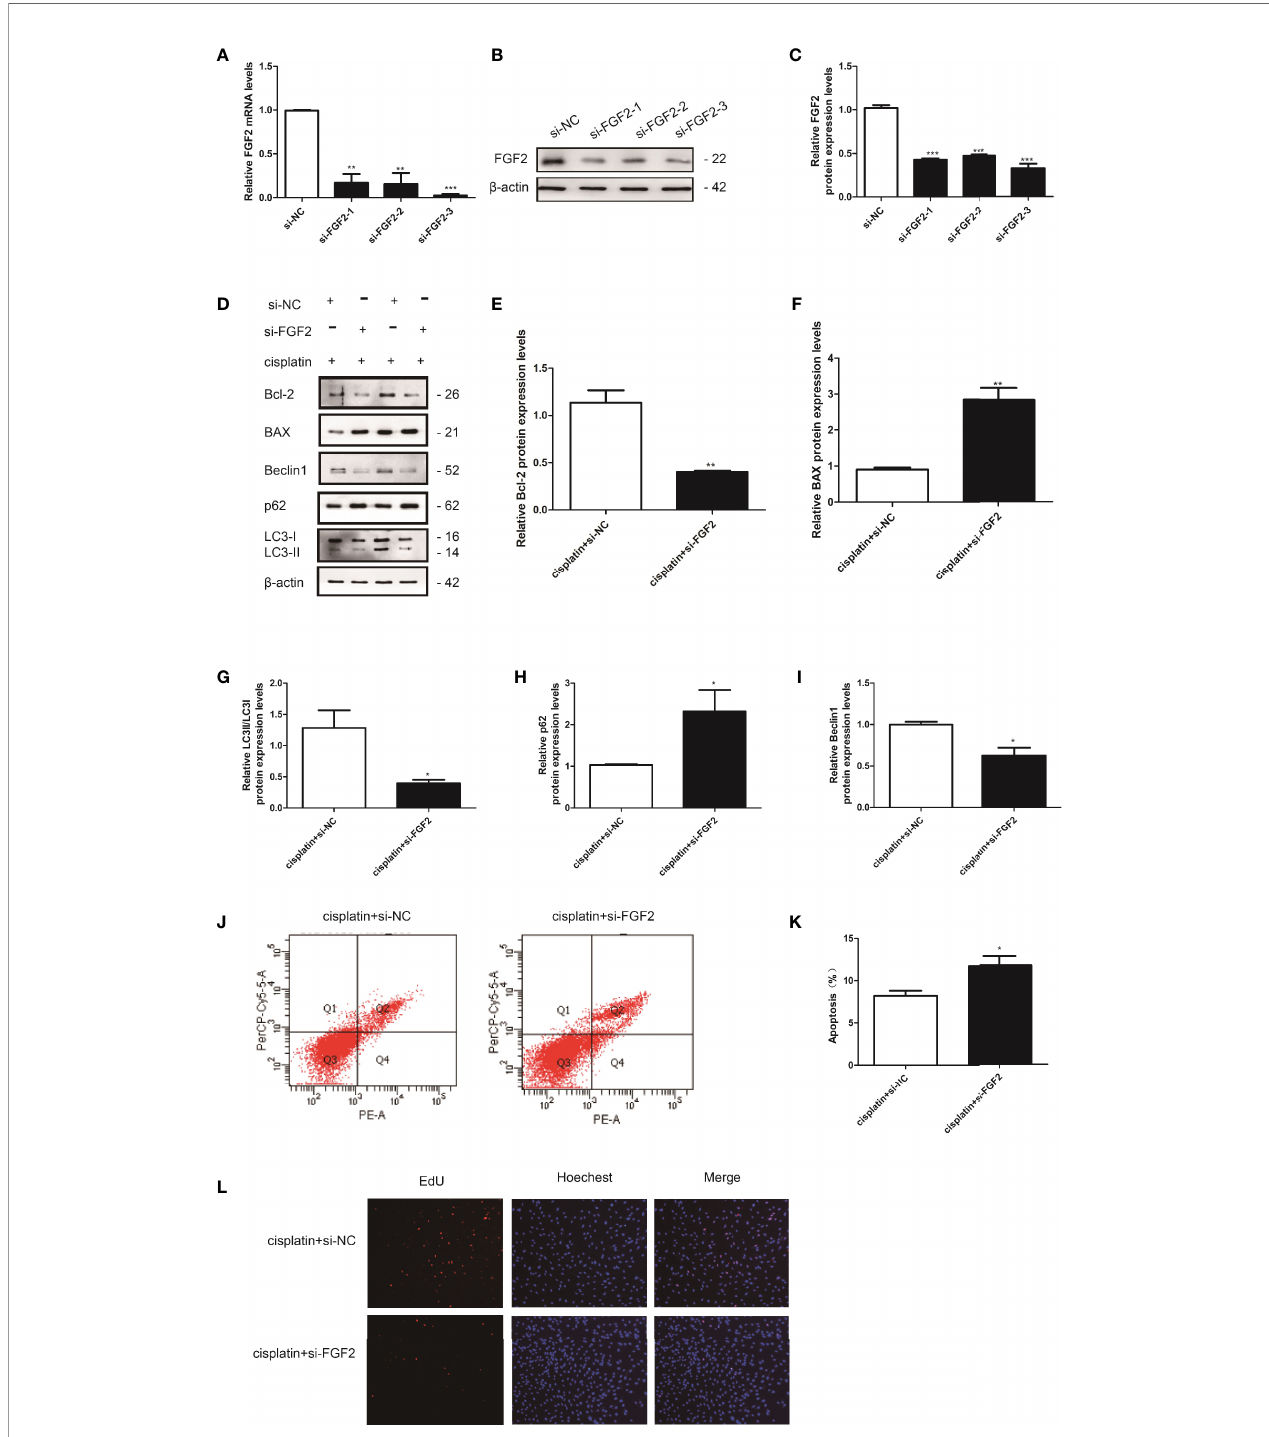
FIGURE 4 | Knockdown of FGF2 in injured KGN cells promoted cell apoptosis via inhibiting autophagy. (A – C) The transfection ef fi ciency was con fi rmed by qRT- PCR and Western blotting. (D) The injured KGN cells were transfected with si-FGF2 (50 nM) for 48 h. The expression of Bcl-2, BAX, LC-3, Beclin1, and p62 was monitored by Western blot. Here, b -actin was used as a loading control. (E – I) Quantitative comparison of the different expression levels of Bcl-2, BAX, LC3, Beclin1, and p62. One-way ANOVA followed by Tukey ’ s multiple comparison test. The results were shown as mean ± SEM from three independent experiments ( a = 0.05, * P < 0.05, ** P < 0.01, *** P < 0.001). (J, K) Flow cytometry assays were performed to determine the effect of si-FGF2 on injured KGN cell apoptosis. A quantitative analysis of the rate of apoptosis was performed. (L) EdU labeling assay was used to detect cell viability. Hoechst was used as a DNA/nuclear